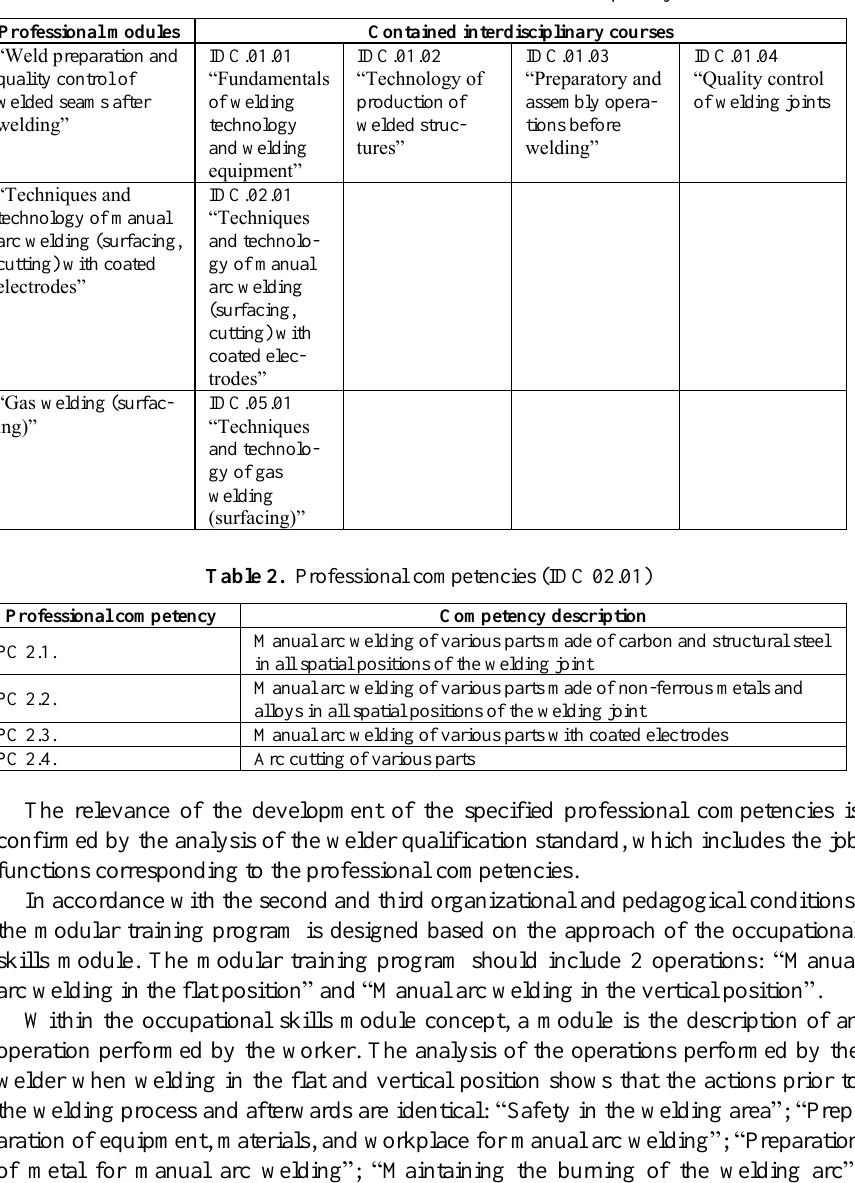
Table 1. Professional modules and contained interdisciplinary courses